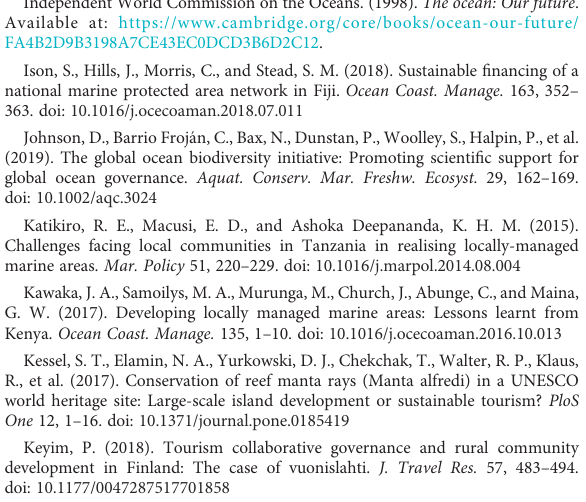
Figueiredo, T. (2020). Viability assessment of a MEET ecotourism product around brijuni national park , Croatia . https://repositorio.ul.pt/handle/10451/